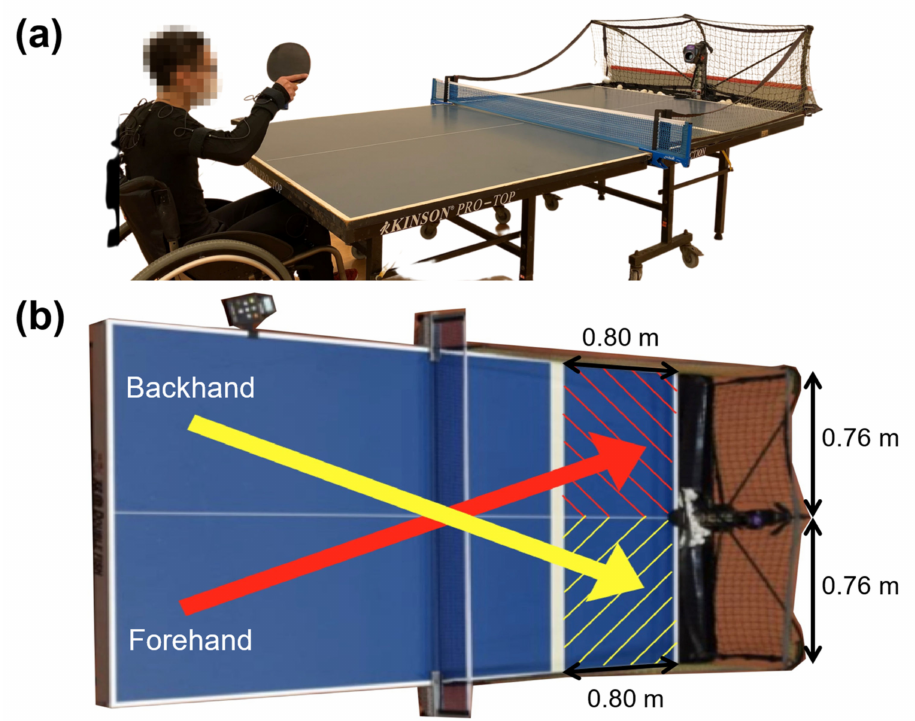
Figure 2. ( a ) Experimental setup using the table tennis table, net set, balls, and Newgy Robo-Pong 2050; ( b ) dimensions (0.80 m × 0.76 m) for valid forehand (red) and backhand (yellow) topspin drives. Balls are projected to oscillator positions 15 and 5 for forehand and backhand topspin drives,